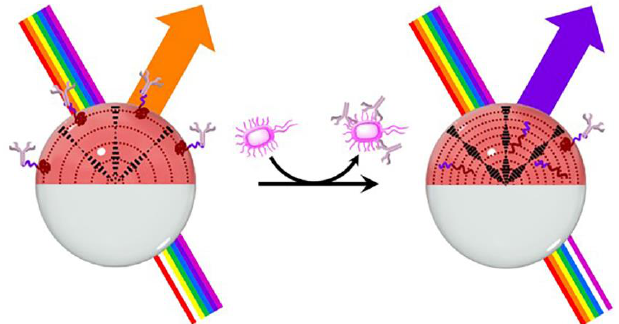
Figure 10. Schematic illustration of the mechanism for the detection of Salmonella enterica using chi- ral nematic (N*) complex emulsions. Changes in the reflected light are produced through changes in the interfacial activity of boronic acid polymeric surfactants induced by a competitive binding/unbinding of IgG antibodies at the LC/W interface. Reprinted with permission from ref. [152]. Copyright 2021 American Chemical Society.